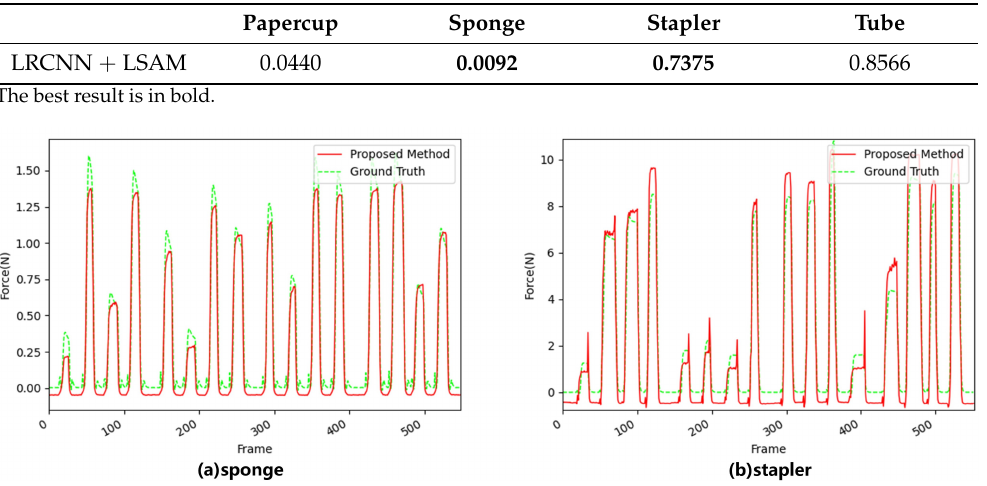
Figure 12. Performance when using LSAM separately for ( a ) the sponge and ( b ) the